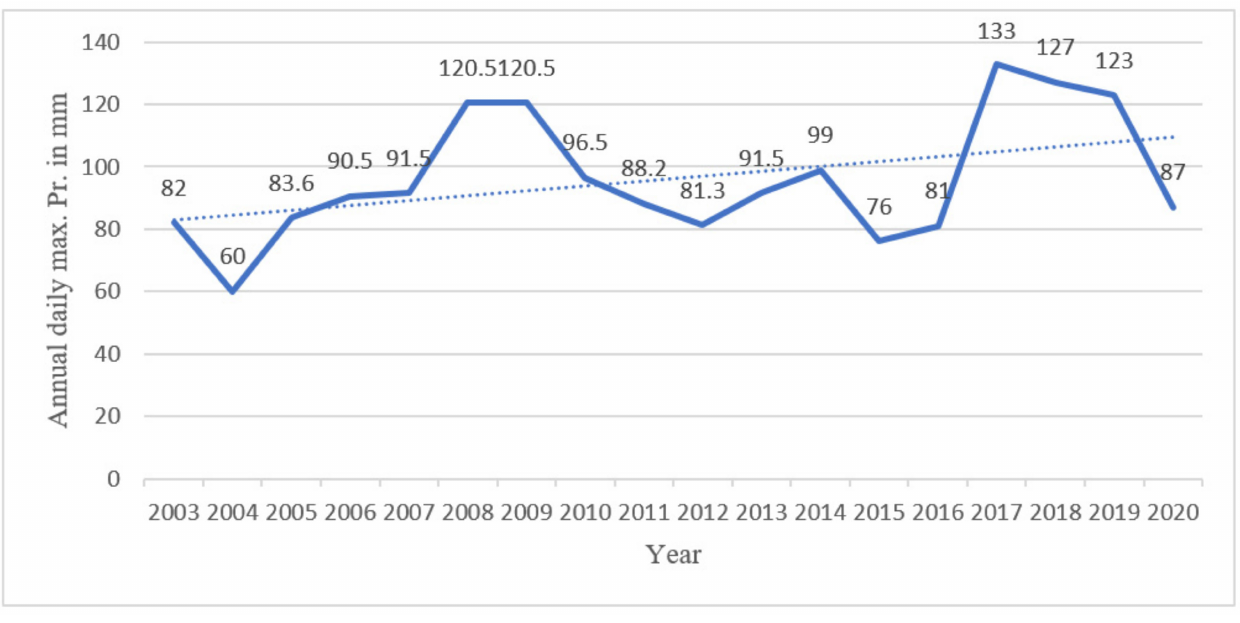
Figure A2. Observed annual daily maximum precipitation of Bobang,